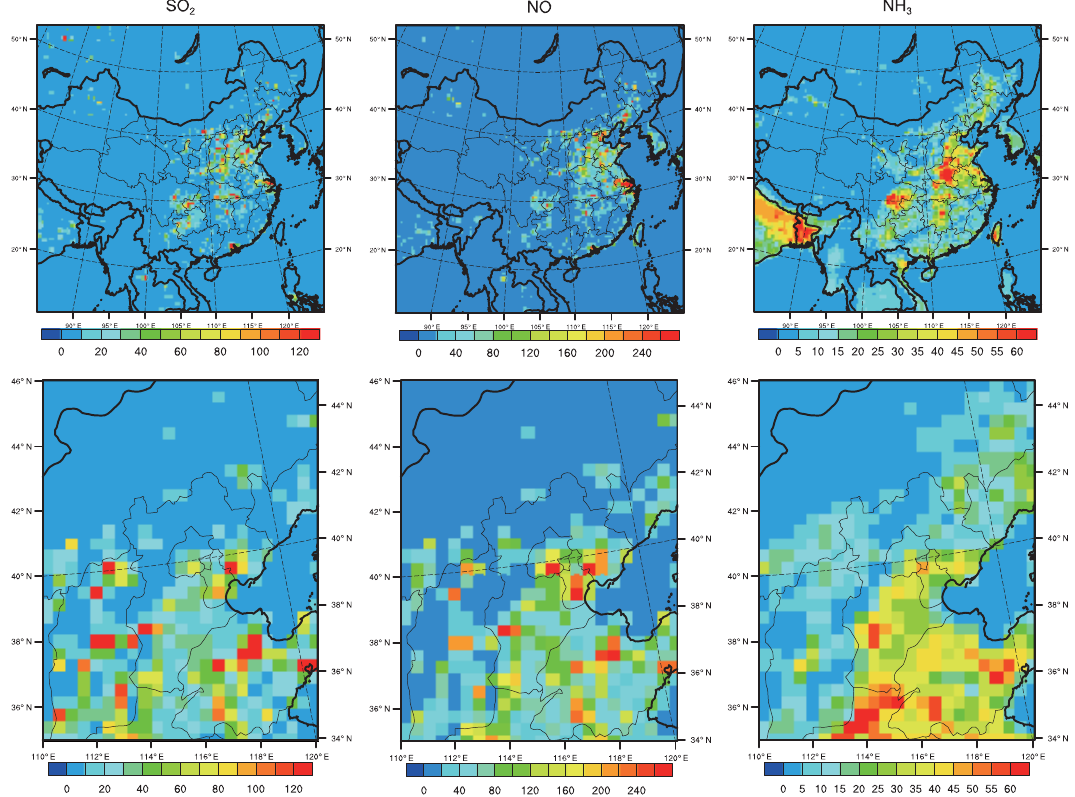
Figure 2. Spatial distribution of SO 2 (left), NO (middle), and NH 3 (right) emissions over the model domain (top panels) and in NCP (bottom panels). Units are in molkm − 2 h − 1